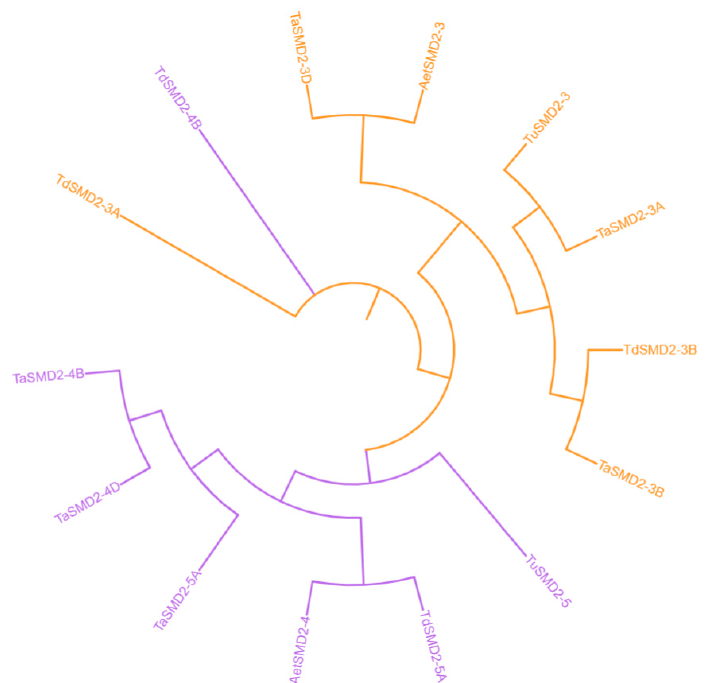
Figure 3. Unrooted phylogenetic tree representing the relationships among the SMD2 gene in wheat and its progenitors. Purple represents the SMD2 gene on chromosomes 5 and 4, and orange represents the SMD2 gene on chromosome 3.